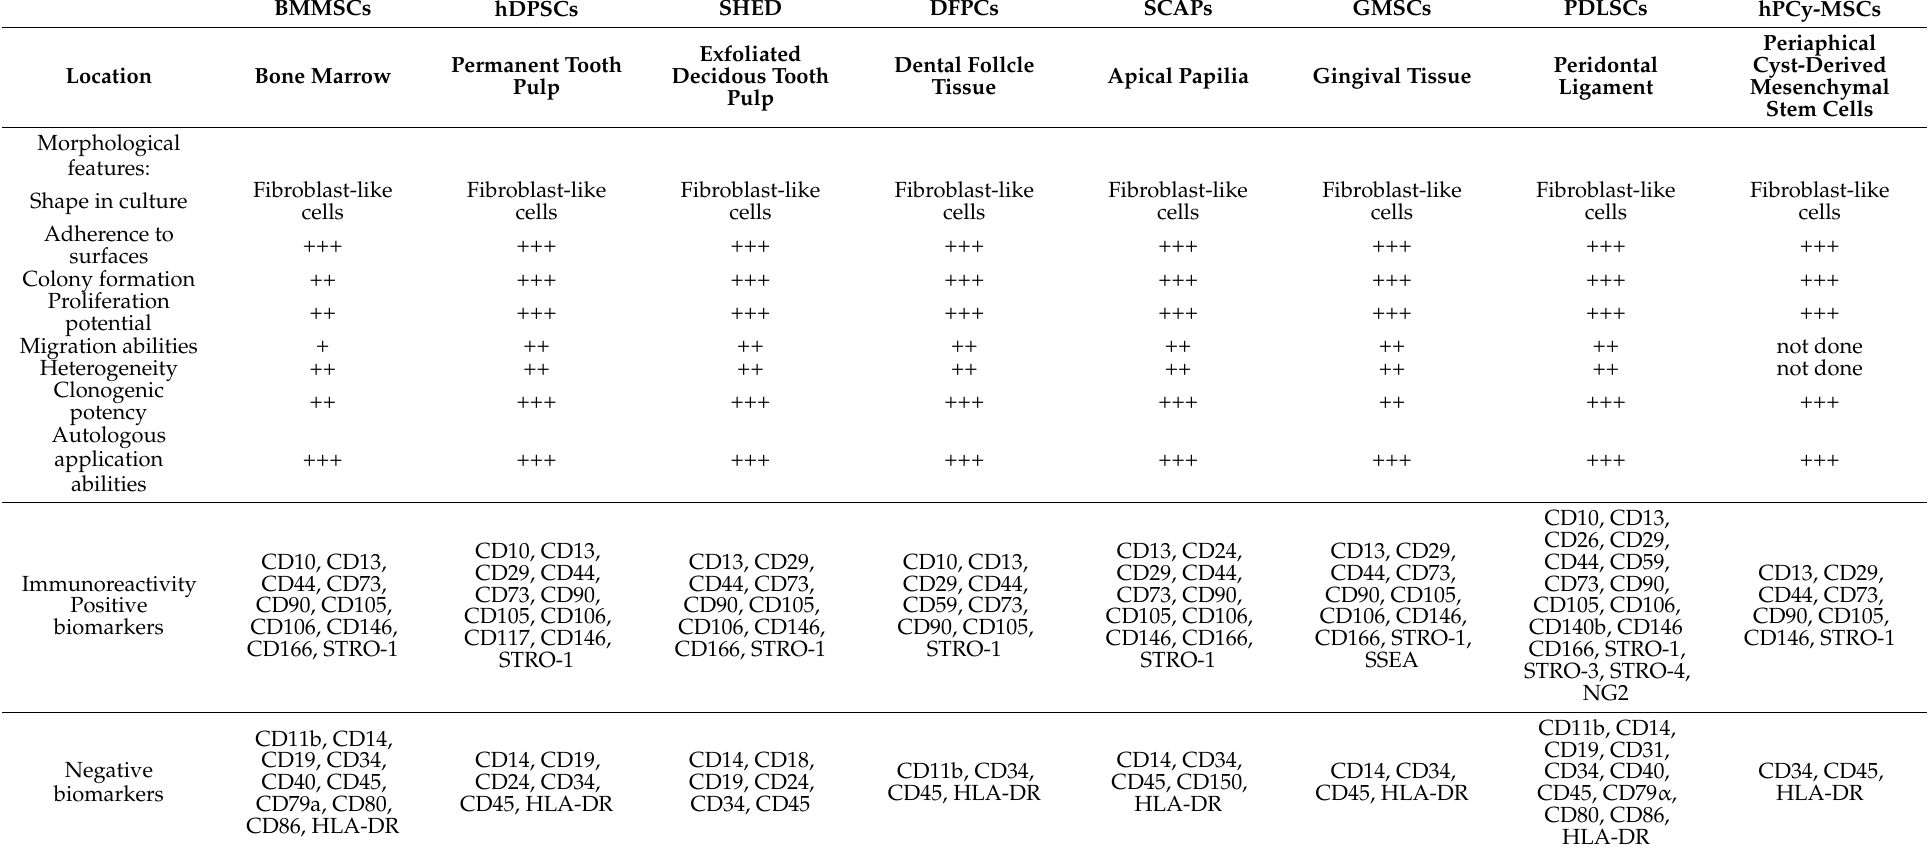
Table 1. Biological features and multipotency capacity human mesenchymal stem cells from bone marrow and dental